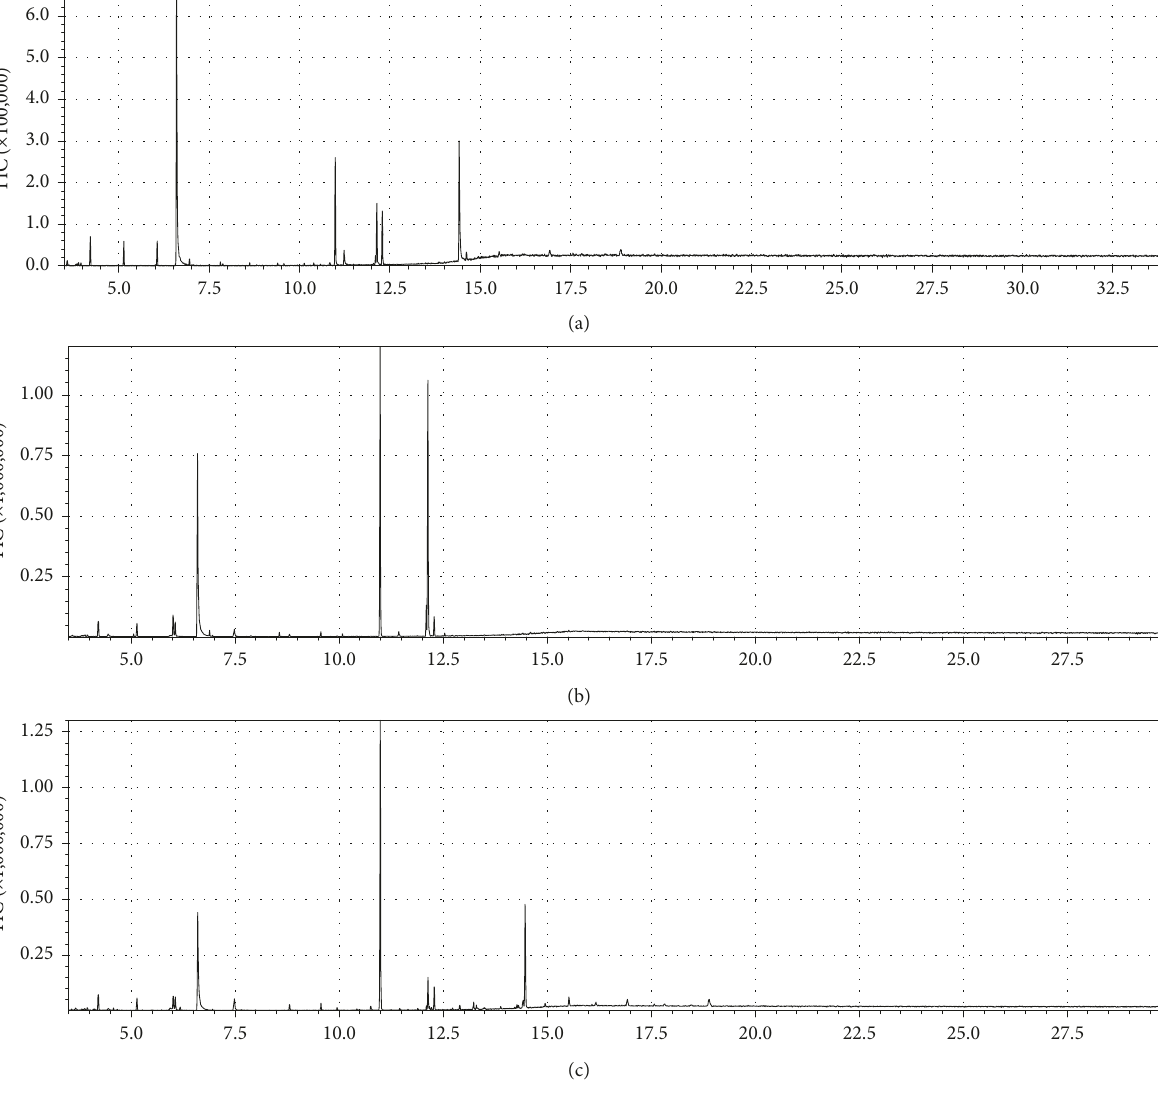
Figure 1: Representative typical GC-MS total ion current (TIC) chromatograms of three shammah samples. (a) S1 (pet. ether); (b) S2 ethanol; (c) S8